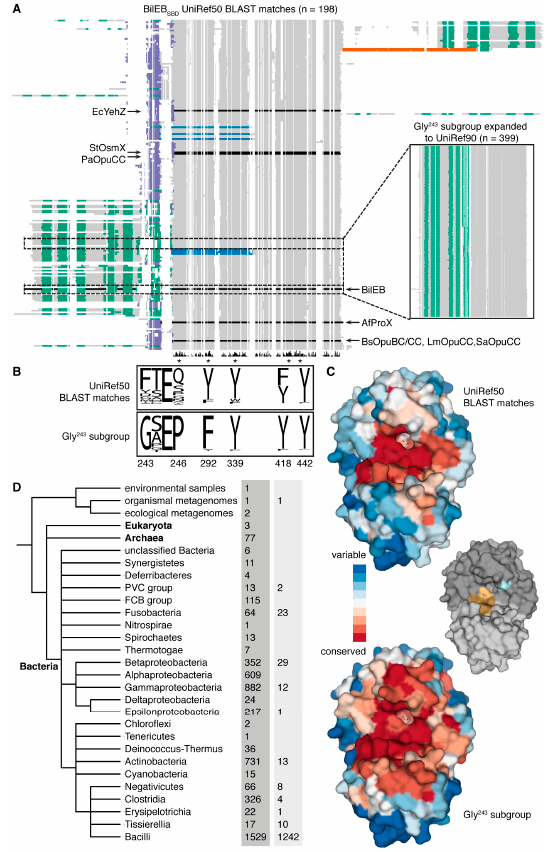
Figure 4. Conservation of BilEB: ( A ) Multiple sequence alignments of UniRef50 (main) and UniRef90 (inset) reference sequences. Reference sequences for clusters containing SBPs discussed in this paper are shown in black. The reference sequence for the cluster containing PsOpuCC was removed during an automated trimming step. Topology predictions made by TOPCONS [35] are shown in green (TMSs) and purple (signal sequences). Orange indicates an additional SBP fold as predicted by HHpred [36]. Where sequences were manually altered to reflect a change in the primary sequence compared to the predicted tertiary structure (as described for Bacillus subtilis OpuAC), the shifted C-terminal portion is shown in blue. Dashed outlines indicate sequences containing a Gly residue at the position corresponding to Gly 243 of BilEB. The histogram below the main alignment shows the sequence conservation. ( B ) Frequency plots showing the distribution of amino acids at corresponding positions of each alignment. Numbering shown is according to BilEB. ( C ) The ConSurf server [56] was used to map the conservation of each alignment onto the BilEB SBD structure. A molecule with the same color scheme as Figure 3 is included for clarity. Domains A and B are shown in dark grey and light grey, respectively. Residues predicted to form a cage around the quaternary ammonium are dark gold except for Phe 292 , which is pale gold. Gly 243 and Pro 246 are colored pale blue. ( D ) Phylogenetic distribution of the sequences represented in each alignment. Values shown are the number of unique organisms in each taxa which have sequences in the UniRef50 (left column) or UniRef90 (right column) clusters. Images were prepared using Jalview [57], PyMOL [52], and iTOL [58].